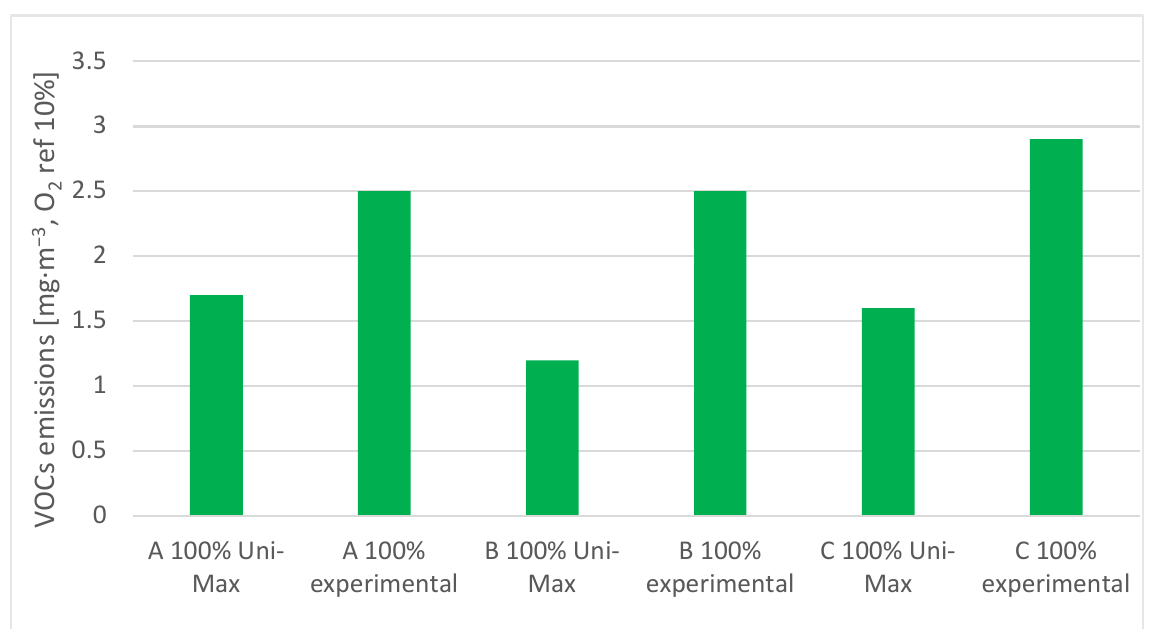
Figure 10. Comparison of average statistical VOCs emissions from the combustion of three types of wood pellets in two different burners at full load.